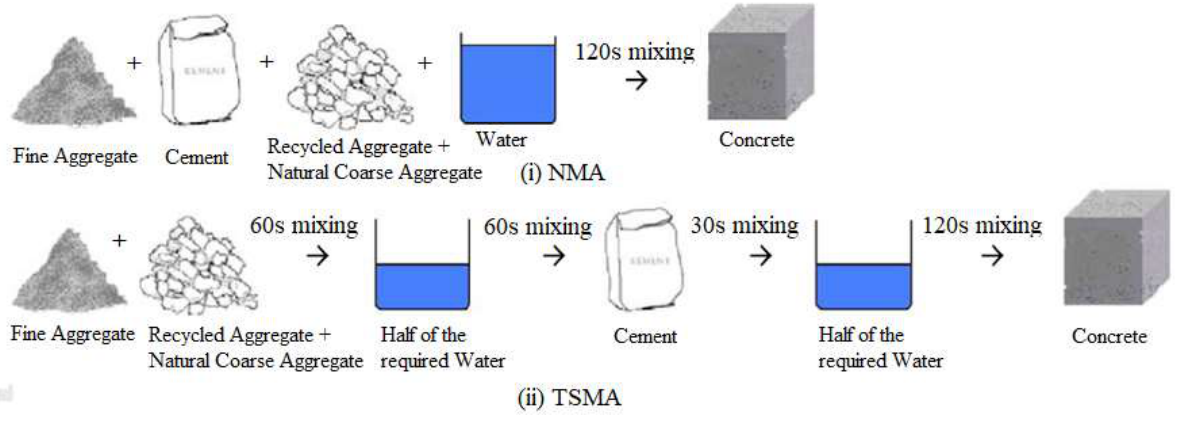
Figure 9. Mixing procedure of the ( i ) normal mixing and ( ii ) two-stage mixing approach [42]. Reproduced with permission from [42], Elsevier, 2005.